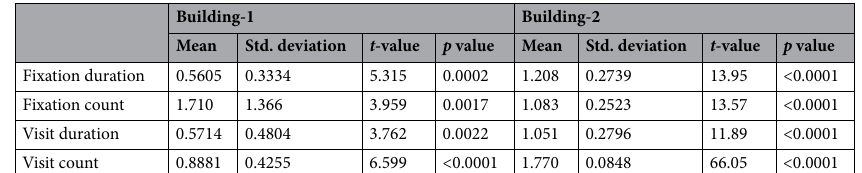
Supplementary Table. 1 for detail.